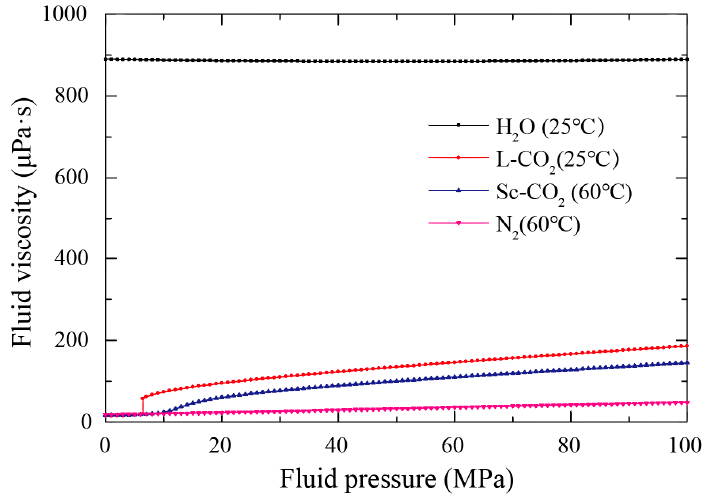
Figure 12. The evolution of fluid viscosity against the pressure of fluids.